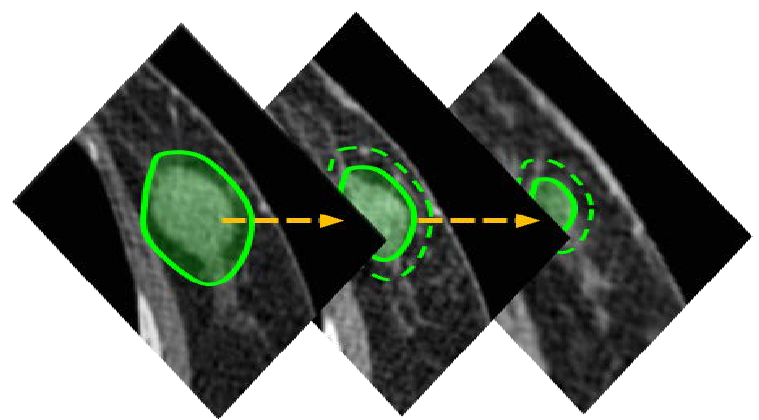
Figure 3. Process of seed region propagation.